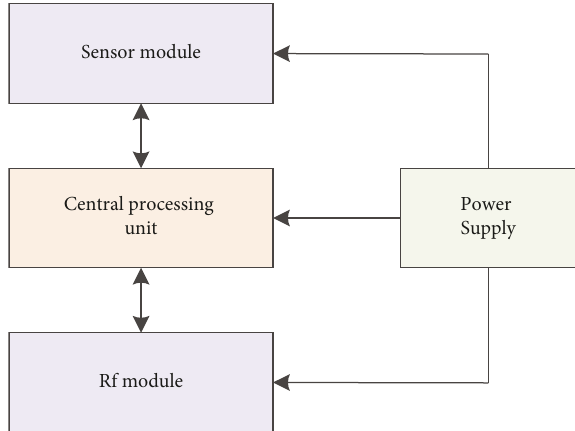
Figure 4: Wireless sensor node basic block diagram.